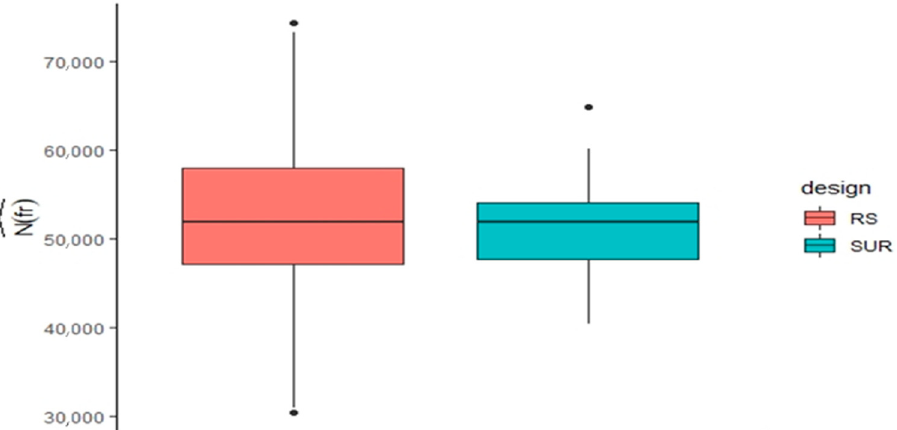
Figure 3. Comparison of two sampling strategies, RS and SUR, in estimation of total fruit load (N (fr) ) in a mango orchard in which the fruit number on every tree is known (site 1 in Table 3). The orchard has 469 trees and high variability in tree fruit load, with an average of 88 and SD = 89 fruit per tree (CV = 81%). The boxplots present estimates of fruit loading based on 250 realizations of 26 random samples using RS, compared to SUR sampling of rows with period 2 and trees-in-rows with period 9, for a mean sample size of 26 trees. ,